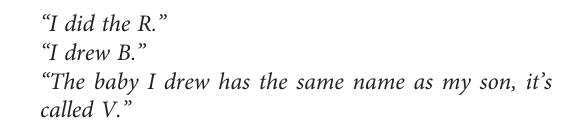
TABLE 1 | Presentation of the axis and main themes. Axes Themes Baby representation Baby that stays/Baby that leaves Imaginary bay/Real baby Naming of the babies The baby caregiving